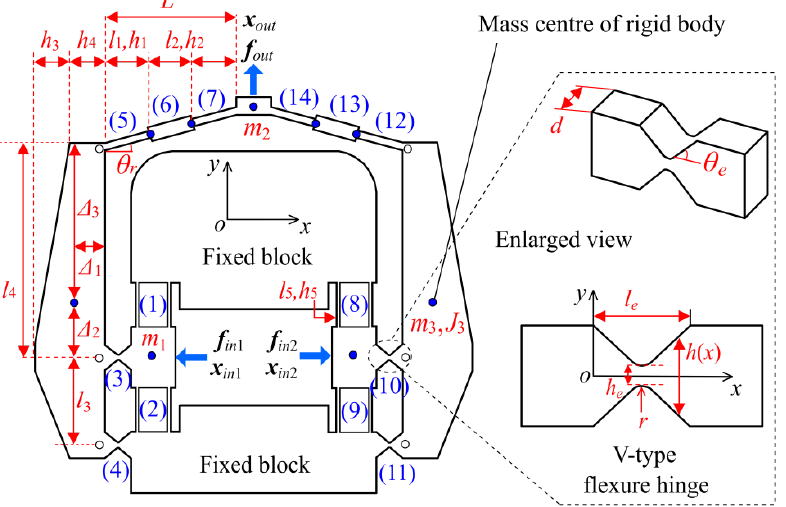
Figure 5. Geometric parameter, discretization, and numbering of the displacement amplification mechanism. f in , f out , x in , and x out with the subscripts 1 and 2 denote the input/output forces and displacements. Numbers from (1) to (14) denote the elements of flexure beams/hinges. m with the subscripts 1, 2, and 3 are the mass of lumped mass and rigid bodies. Other variables denote the geometric parameters of the displacement amplification mechanism.